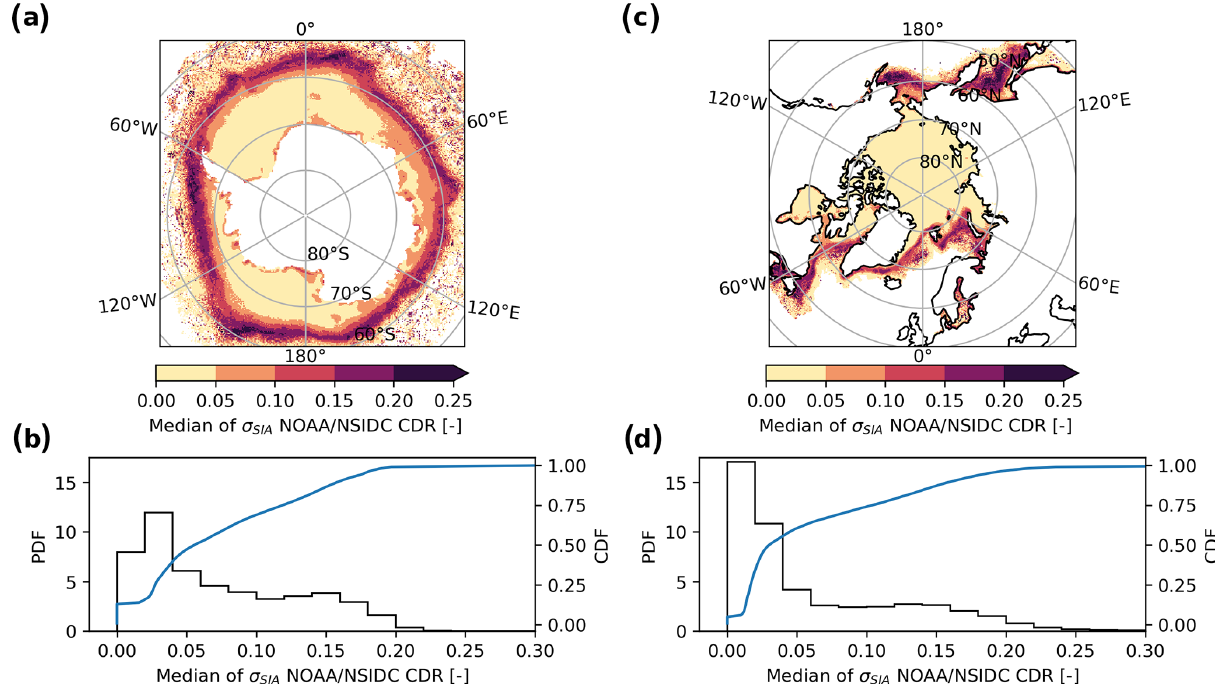
Figure 3. (a) Median of the σ SIA indicator on a stereographic projection. The pixels with SIC = 0 and σ SIA = 0 have been excluded from the analysis. (b) Empirical probability and cumulative density functions of the median values from the map shown in panel (a) (probability density function, PDF: black line; CDF: blue line). (c,d) Same as (a,b) but for the Arctic. All data are from the NOAA/NSIDC CDR